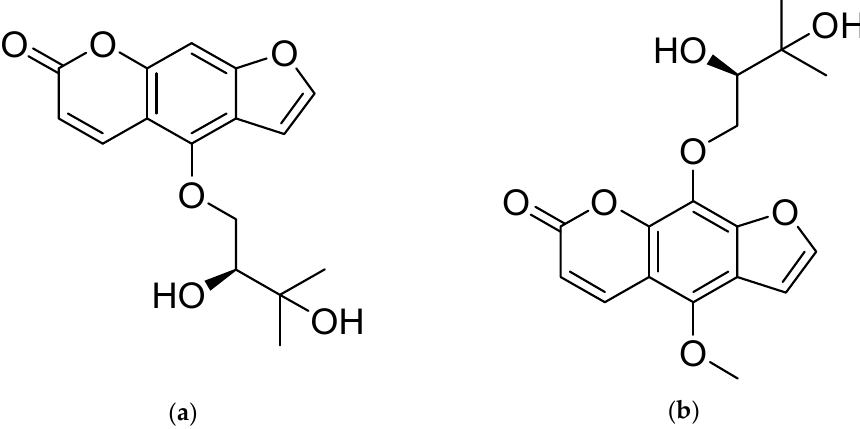
Figure 1. Chemical structures of ( a ) Oxypeucedanin hydrate, ( b )